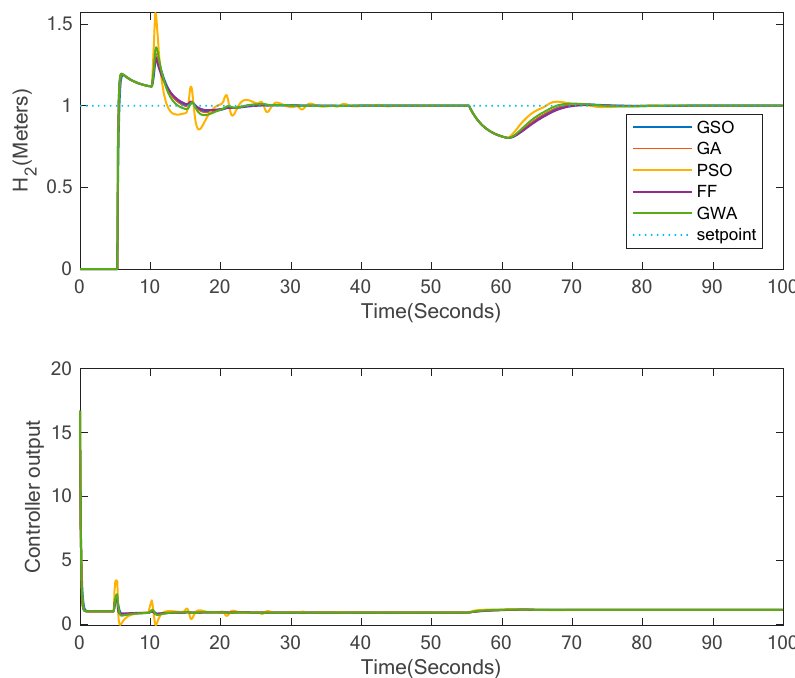
Figure 15. Example 1: Regulatory response with the RTD-A controller using optimization algorithms.